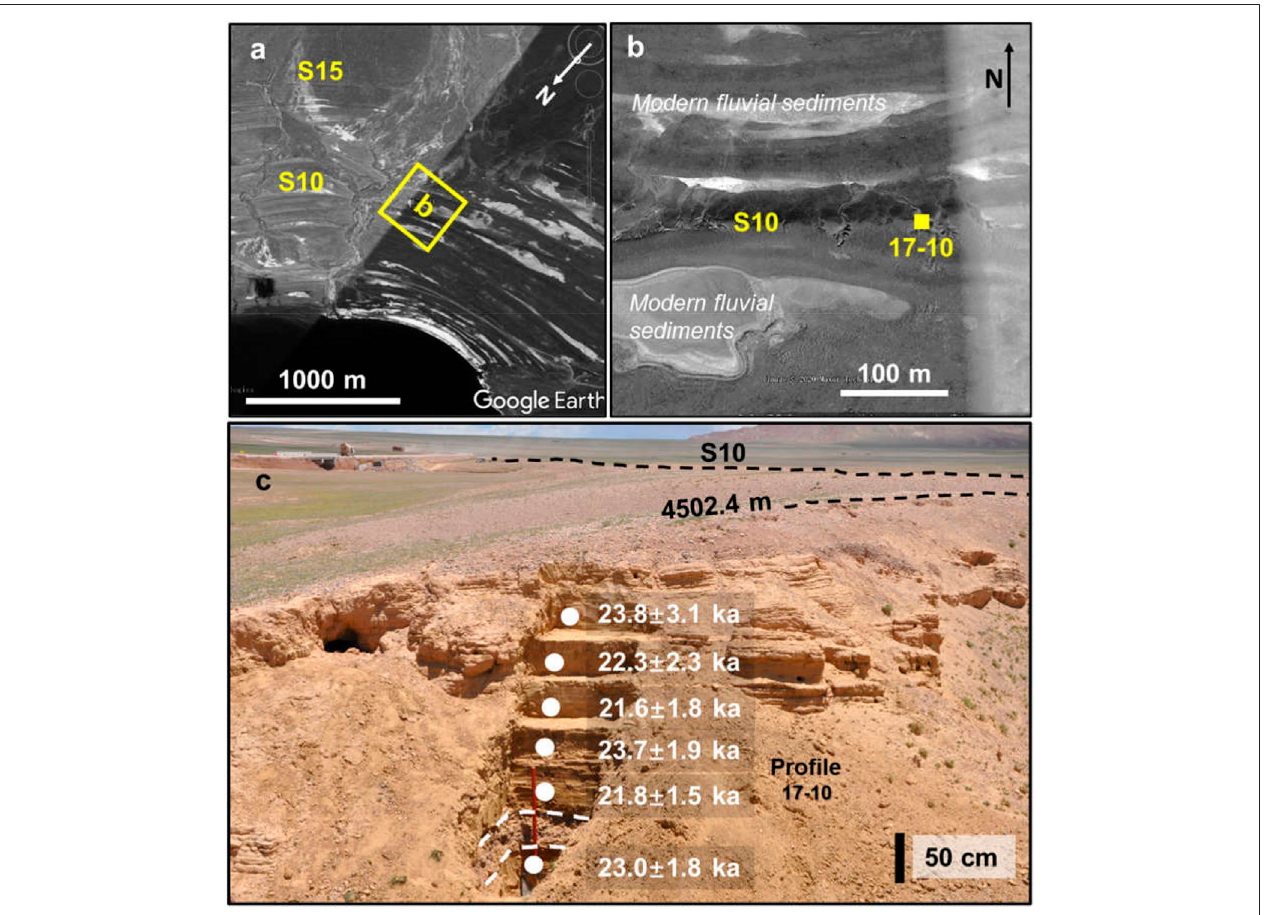
FIGURE2|(A) ViewofDagzeCoandthepaleoshorelineslocatedonthesouthernlakemargin. (B) enlargementofthehollowsquareregionoutlinedinyellowin (A) , the yellow solid square represents the location of pro fi le 17 – 10. (C) Pro fi le 17 – 10 and associated OSL ages. The view is toward the east.